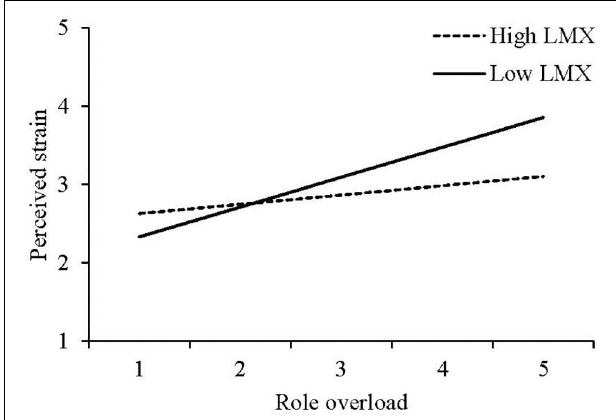
FIGURE 3 | Study 2 Moderating Effect of LMX on the Relationship Between Role Overload and Perceived Strain.